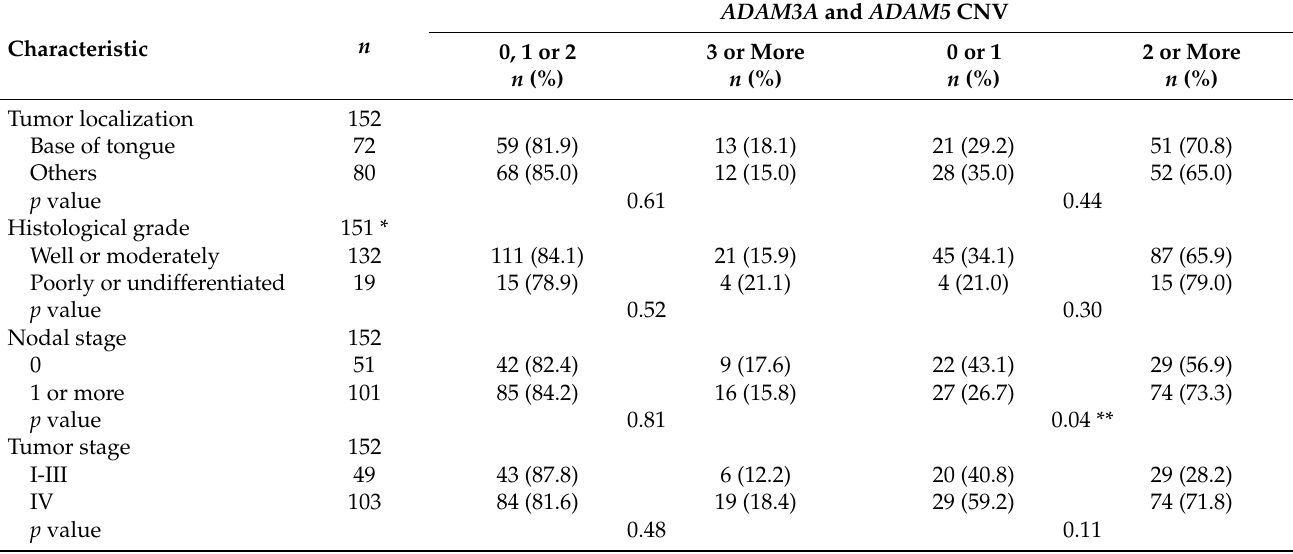
Table 2. Association of clinical–pathological characteristics and ADAM3A and ADAM5 copy number variations of 152 oropharyngeal squamous cell carcinoma